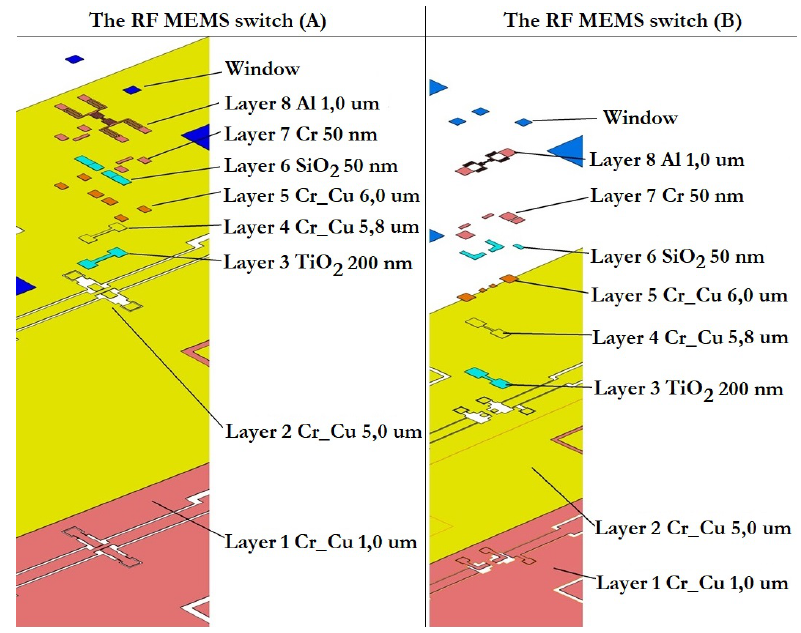
Figure 23. The technological layers in the manufacture of experimental samples.